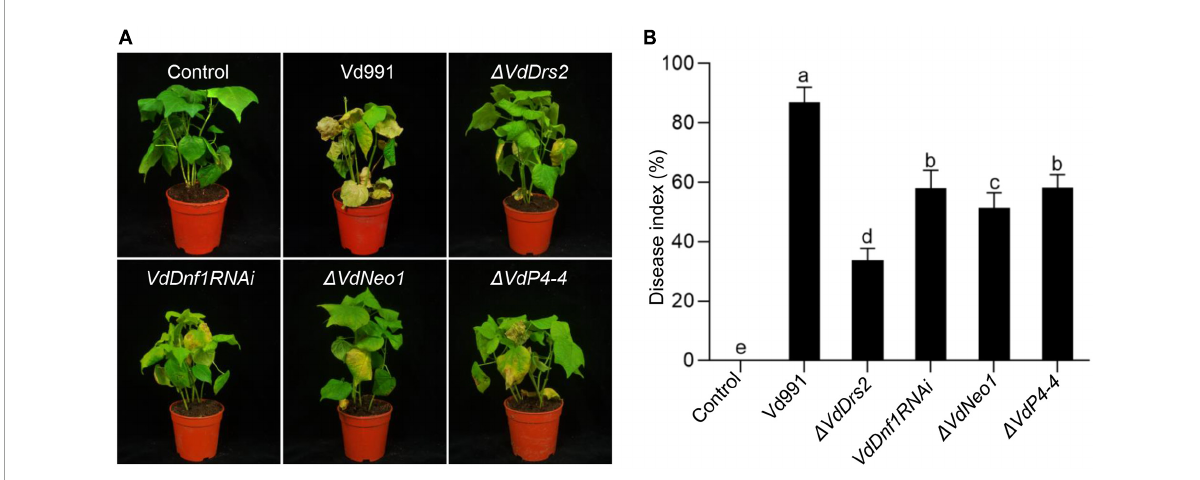
FIGURE1 Knock out of VdDrs2 , VdNeo1 , and VdP4-4 , or knock down of VdDnf1 in V. dahliae reduces the pathogenicity to cotton. (A) Wilt symptom of cotton plants inoculated with spores of knock-out stains ( (cid:49) VdDrs2 , (cid:49) VdNeo1 , and (cid:49) VdP4-4 ), knock-down strain ( VdDnf1RNAi ), and wild type strain (Vd991) by root-dipping method. Control, cotton seedlings were inoculated with sterile water. (B) Disease index of cotton plants inoculated with V. dahliae spores of mutant strains and wild type strain. The grades of disease symptoms are described in the methods. 30 cotton plants were used per treatment. Different letters (a, b, c, d, and e) indicate a significant difference ( P < 0.05) based on one-way ANOVA with Tukey multiple comparisons